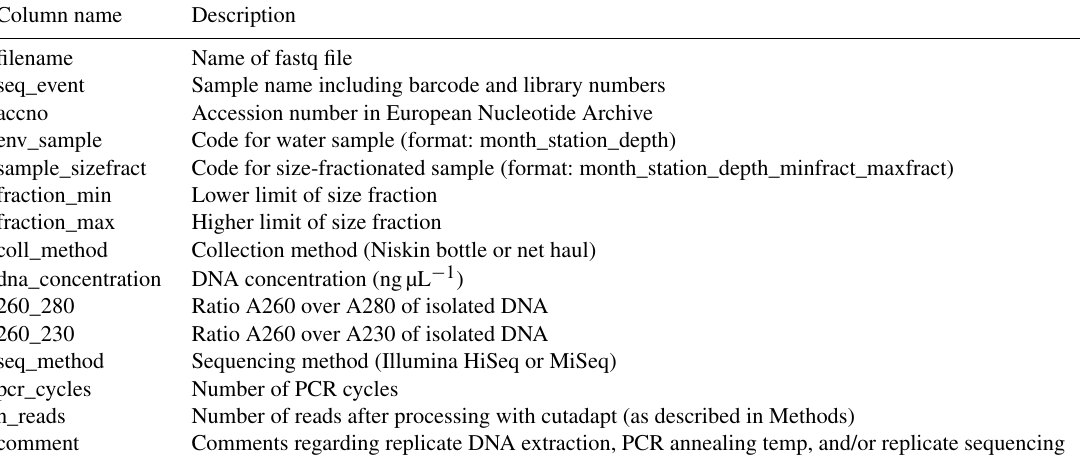
Table 3. Description of metadata table (named “meta_data_fastqfiles.txt”) for the fastq files deposited in ENA. These metadata can be joined with environmental data (described in Table 1) by the “env_sample” column. Each fastq file is unique, but two or more fastq files may map onto the same DNA extract and/or PCR.